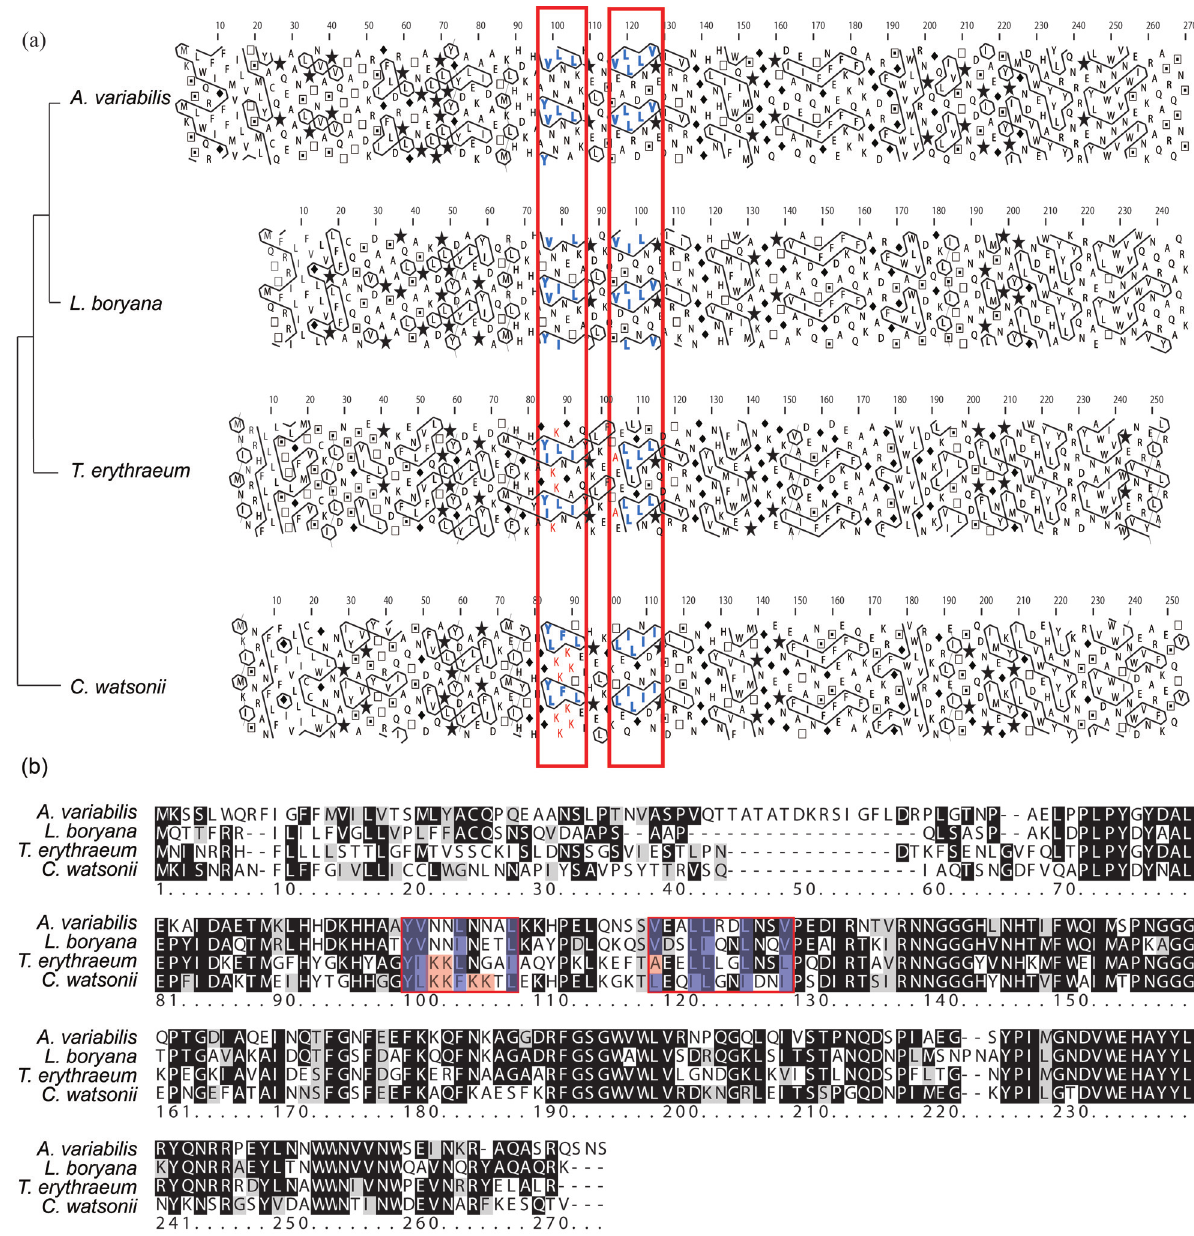
Figure5 -ComparisonoftheHCAstructureandaminoacidsequenceofMnSODsoffourCyanobacteria.Note: C.watsonii showsthesamecontouras L. boryana and A.variabilis butpresentsdifferentaminoacids,thisimplyingpossibleconvergenceinparallelevolution.(A)HCAplotofMnSOD.Thever- ticalredboxesshowregionsofsignificantdifferencesbasedonHCA.AminoacidchangesresultinginchangesintheHCAplotareinred(hydrophilic)or blue (hydrophobic). The phylogram to the left indicates the likely evolutionary relationship of the taxa in order to compare with changes in hydrophobicity.(B)AminoacidsequencedalignmentofMnSOD.Theblackbackgroundshowsregionswheretwoormoreaminoacidsaretotallyidenti- cal, while the gray background indicates changes resulting in similar amino acids. The positions in red (hydrophilic) or blue (hydrophobic) background show changes in hydrophobicity. The red horizontal boxes enclose regions corresponding to the regions enclosed by the vertical boxes in A. The green boxes enclose the positively selected residues detected by PAML in Table